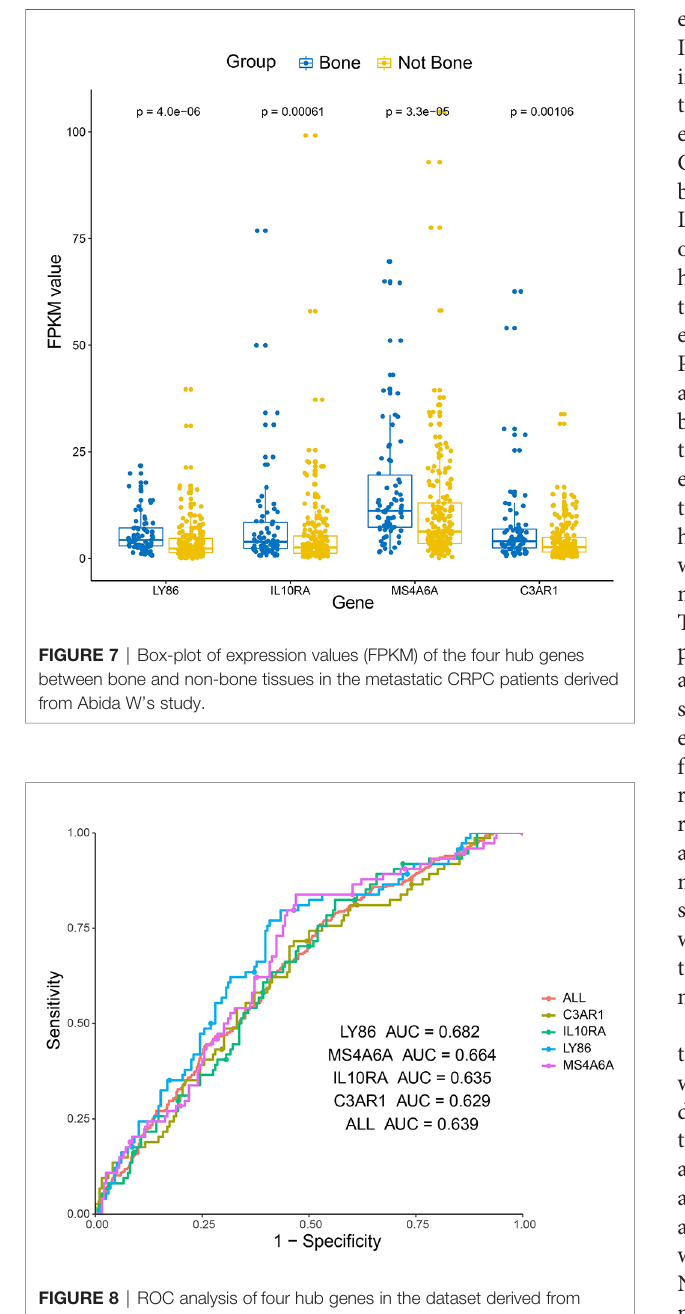
FIGURE 8 | ROC analysis of four hub genes in the dataset derived from Abida W ’ s study. Receiver operating characteristic (ROC) curves and area under the curve (AUC) statistics is to evaluate the capacity of distinguishing bone and non-bone metastatic tissues in the metastatic CRPC